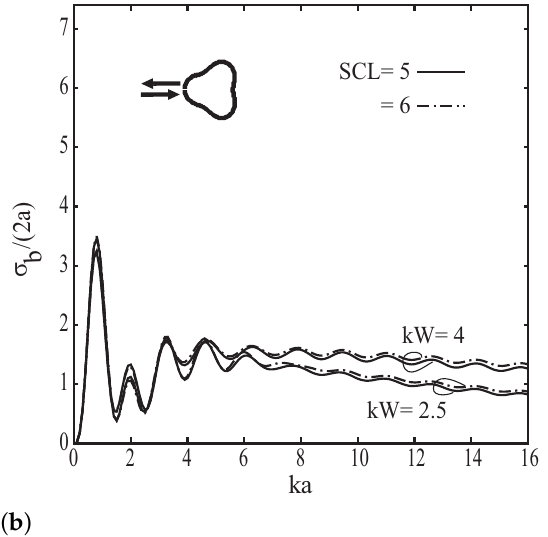
Figure 5. Target size versus LRCS in a disordered medium for a convex illumination region ( θ = π ) where ( a ) δ = 0.08, ( b ) δ =